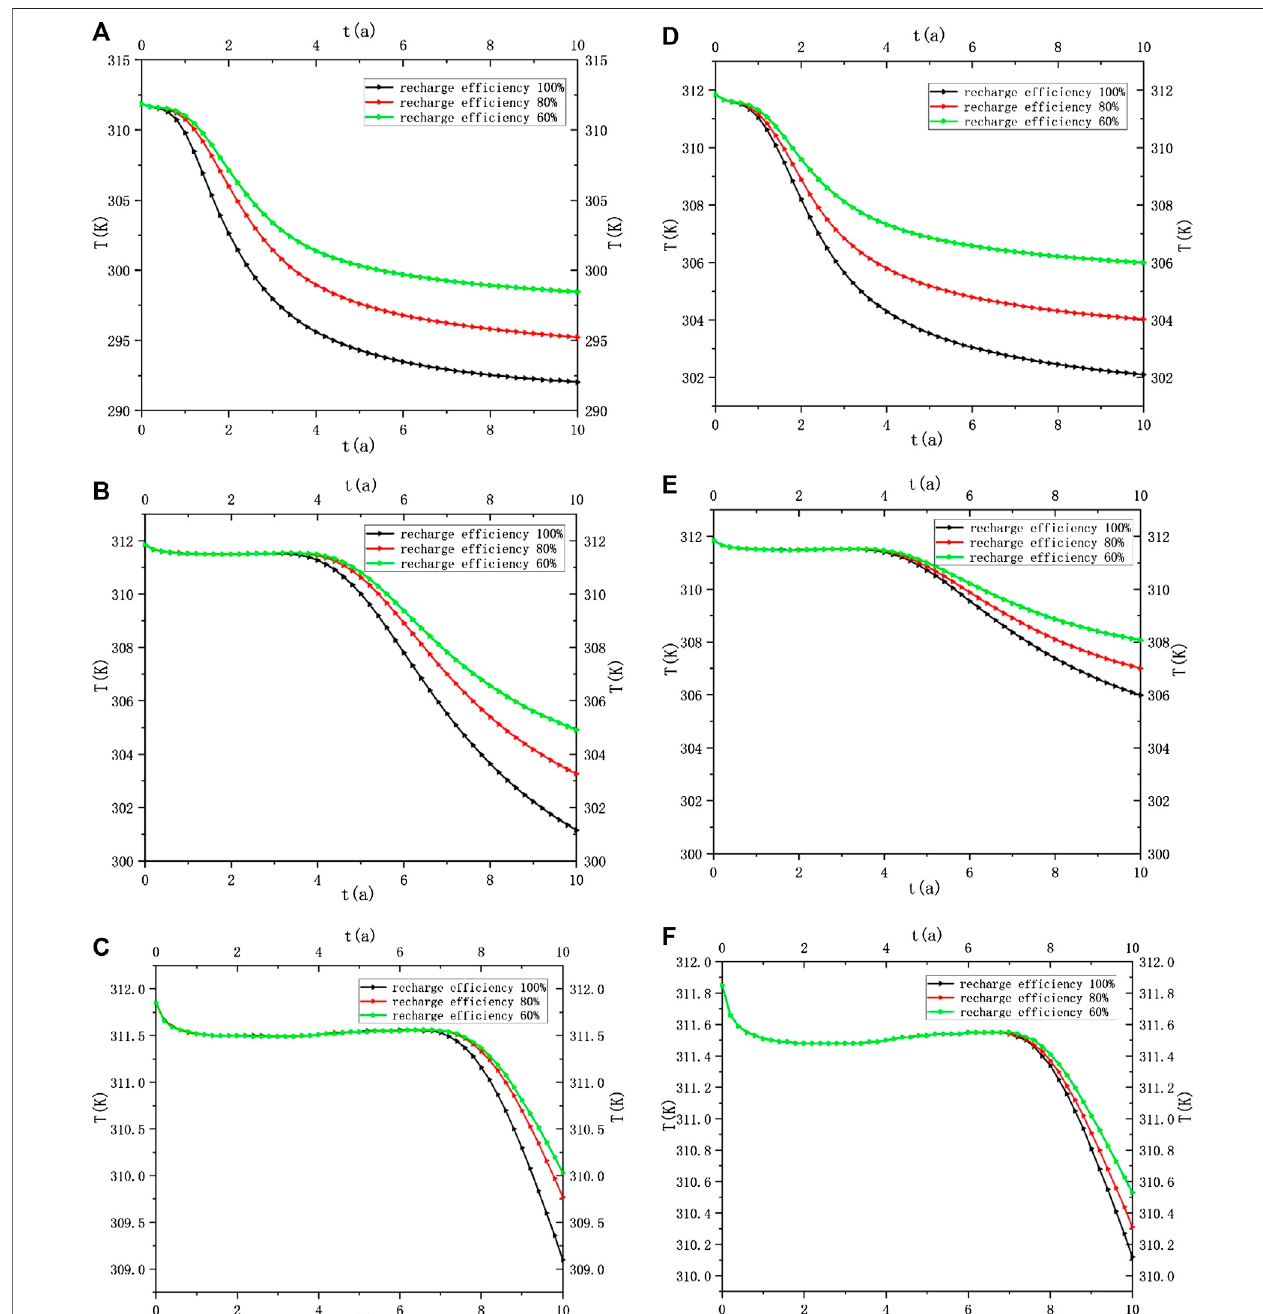
FIGURE4| Temperaturechangesofproductionwellsunderdifferentrechargeef fi ciency. (A) Temperaturechangeofonereinjectionandoneproductionwithawell spacing of 100 m. (B) Temperature change of one reinjection and one production with a well spacing of 300 m. (C) Temperature change of one reinjection and one production with a well spacing of 500 m. (D) Temperature change of one reinjection and two production with a well spacing of 100 m. (E) Temperature change of one reinjection and two production with a well spacing of 300 m. (F) Temperature change of one reinjection and two production with a well spacing of 500 m.